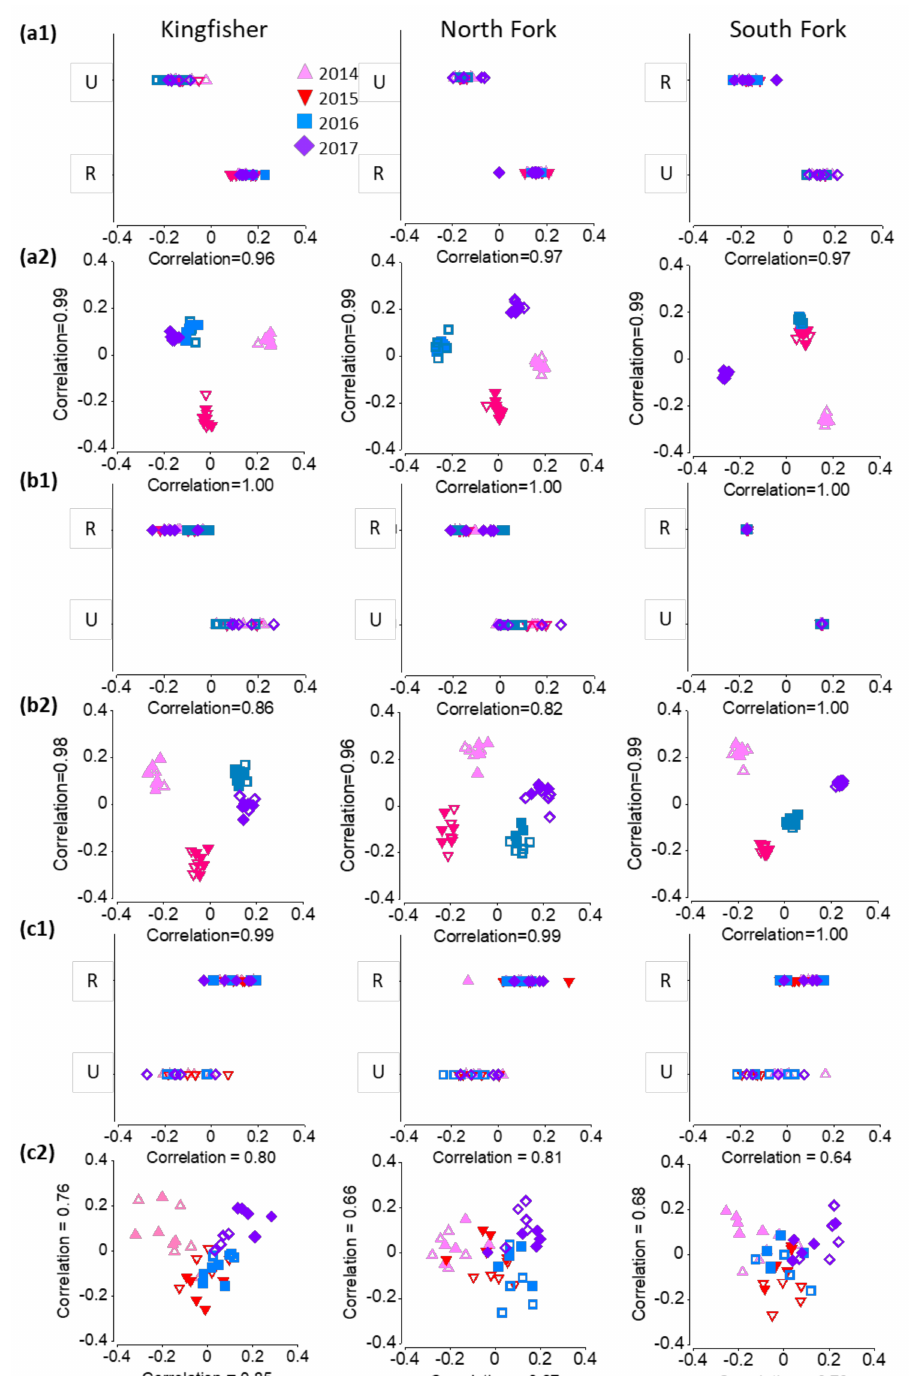
Figure 3. Community composition of ( a ) particle-associated microbes, ( b ) planktonic microbes, and ( c ) invertebrates plotted using canonical correlation to maximize separation by 1. restoration status and 2. year; U = unrestored (outlined symbols), R = restored (filled symbols). For all plots, points closer together are more similar in composition. Axes are labeled with their respective canonical correlation values. Microbe taxonomy is based on standardized log transformed OTU abundances and invertebrate on fourth root-transformed numerical